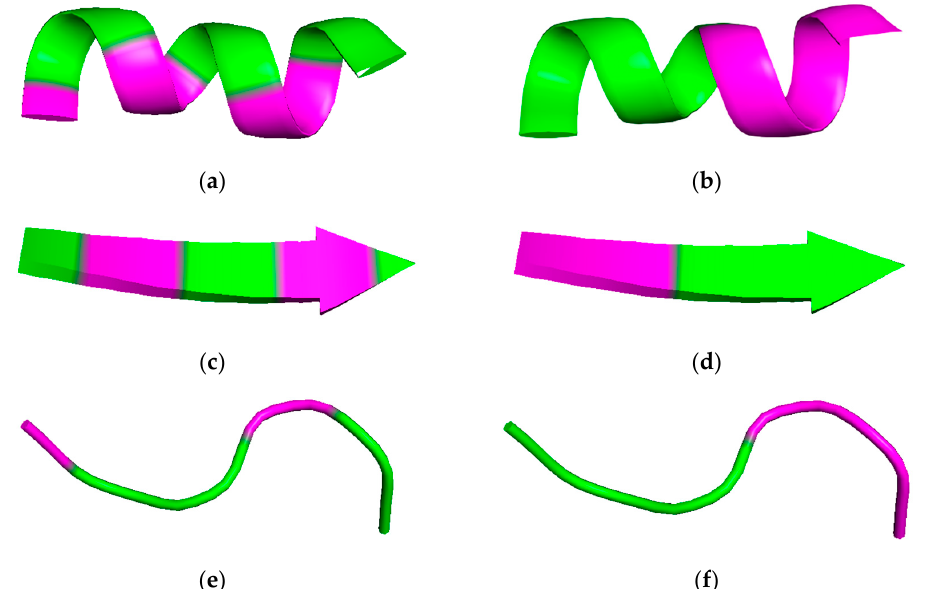
Figure 4. Secondary structures of amphipathic peptides: ( a ) facial α -helix, ( b ) perpendicular α -helix, ( c ) facial β -sheet, ( d ) perpendicular β -sheet, ( e ) facial unordered, and ( f ) perpendicular unordered. Green and purple sections represent hydrophilic and hydrophobic portions, respectively (created with PyMol 2.4.0®, New York, NY 10036-4041, USA).